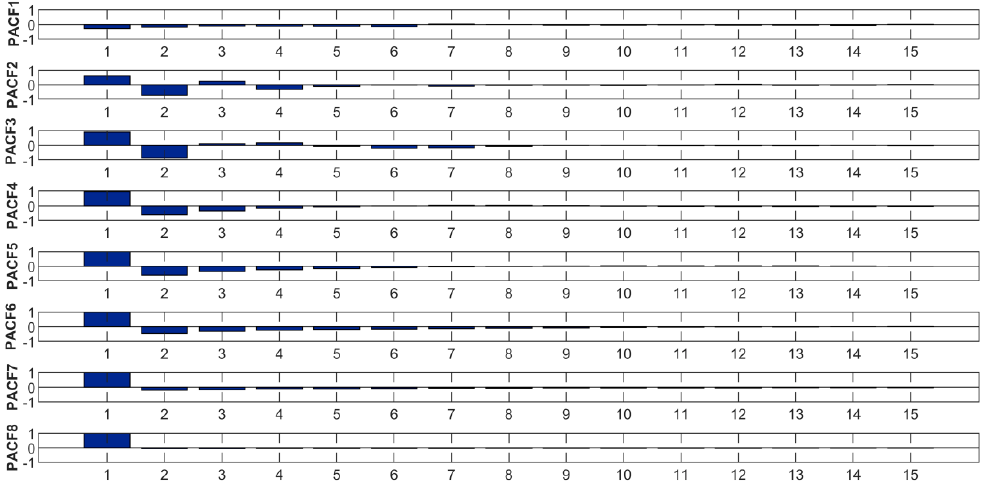
Figure 8. The PCAF results of the Hubei carbon price after ESMD.